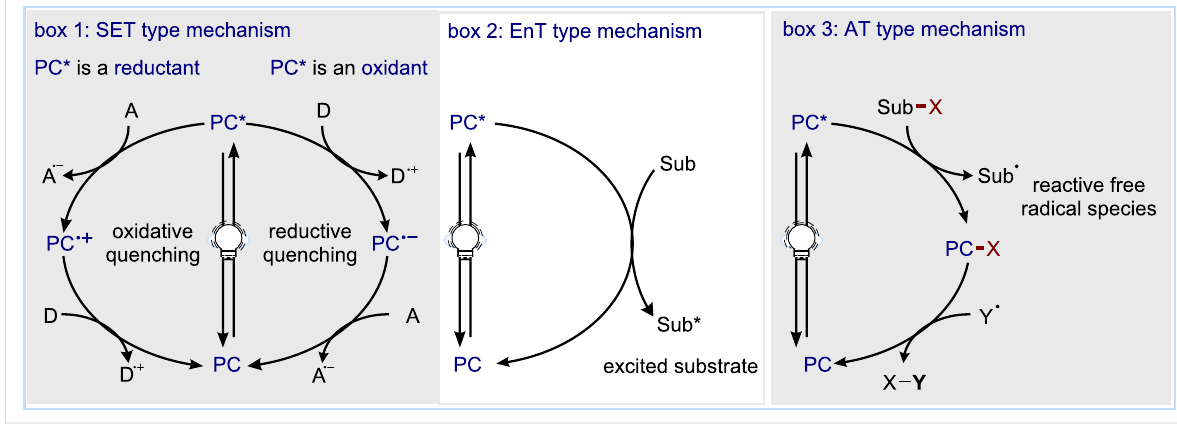
Scheme 1: Activation modes in